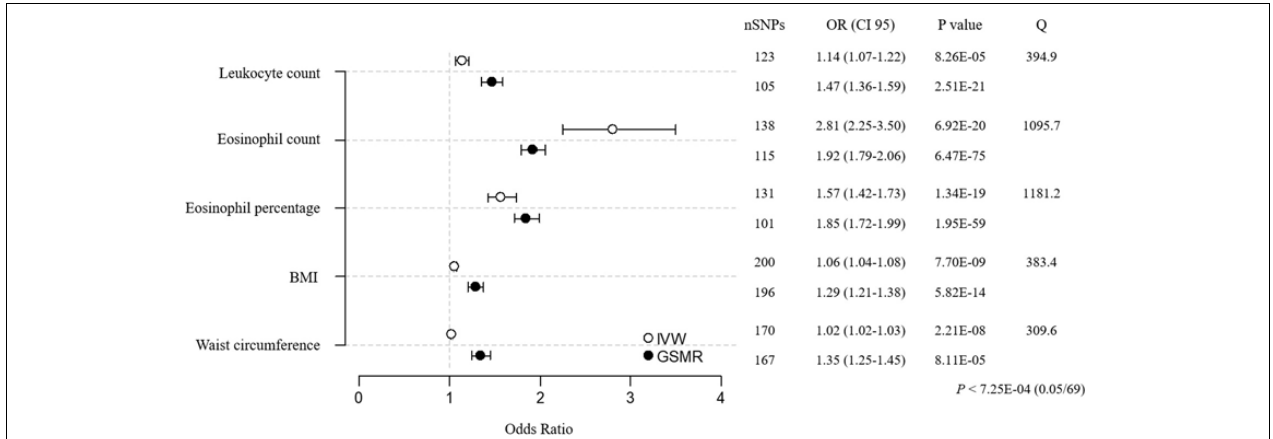
FIGURE 1 | MR estimates for associations between 5 environment factors and asthma. The odds ratio is plotted as dots with the 95% confidence interval. White dots are the IVW method, and black dots are the GSMR method. The P value indicates significance when P < 7.25E-04 (0.05/69) by Bonferroni correction. The Q value by Cochran’s Q statistic indicates residual heterogeneity in the MR